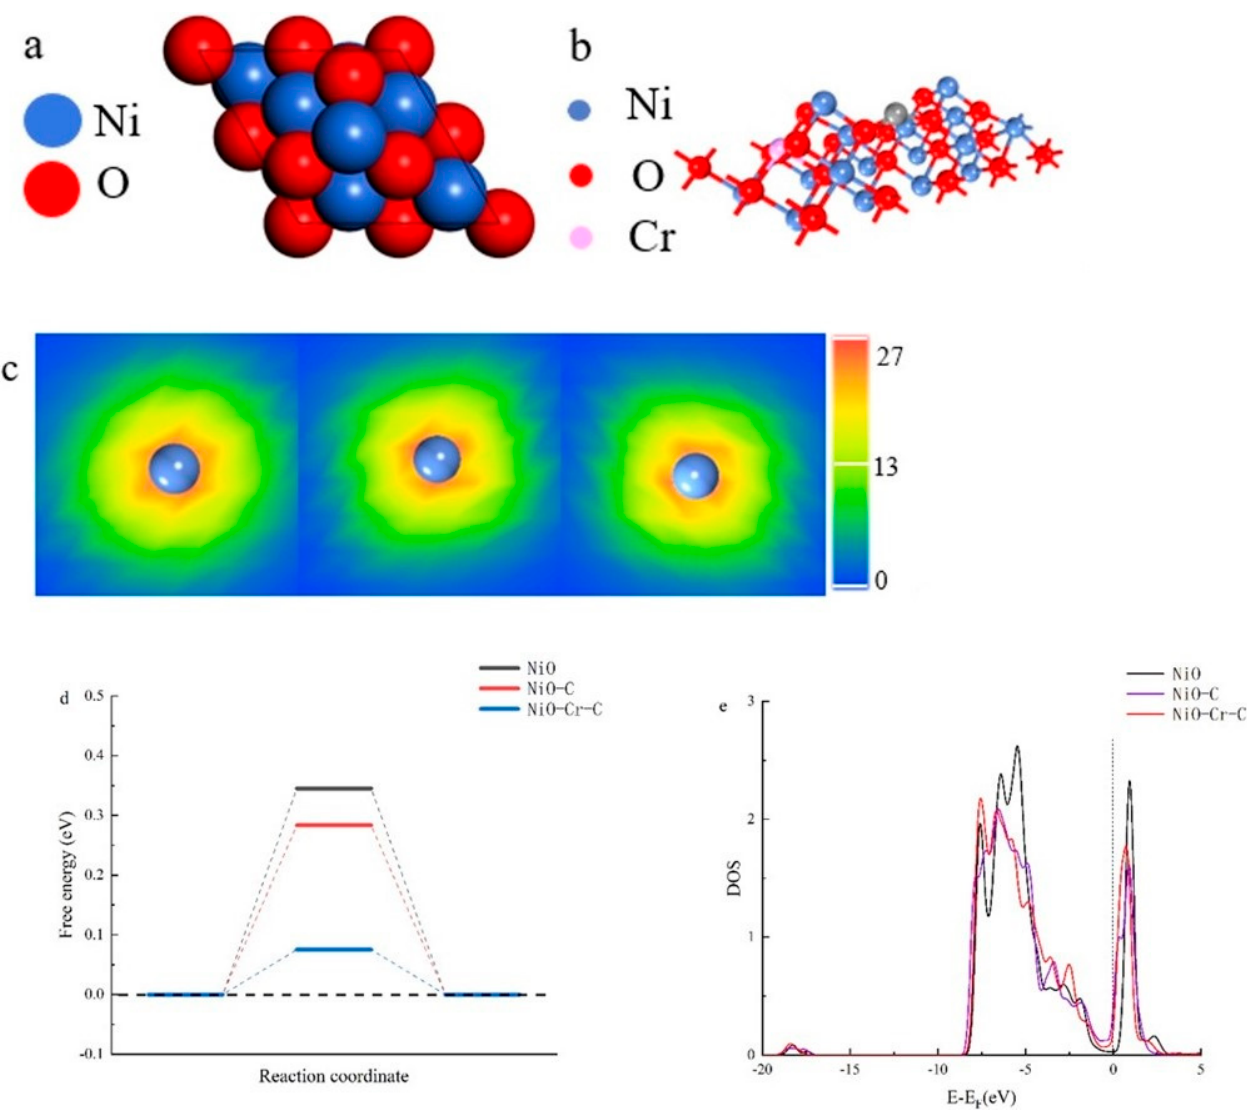
Figure 5. ( a ) Top view of unit cell of Ni terminated NiO (111) surface (Octopolar model). ( b ) Surface structure of NiO-Cr-C. ( c ) Electron cloud density of the top-layer Ni (From left to right represents NiO, NiO-C and NiO-Cr-C). ( d ) Calculated free energy diagram of the HER on NiO, NiO-C and NiO-Cr-C, respectively. ( e ) DOS plots of the top-layer Ni